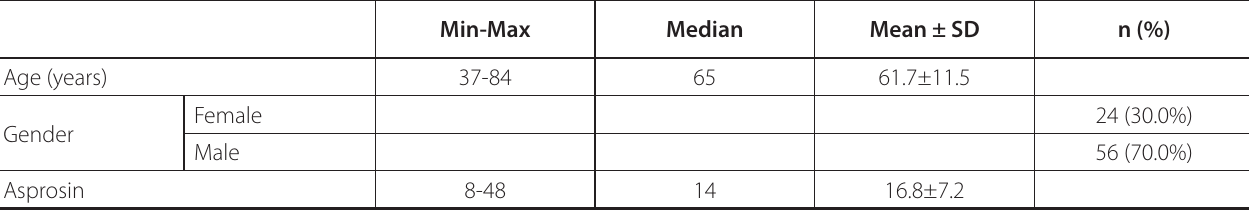
Table 1 . Distribution of cases according to the patients’